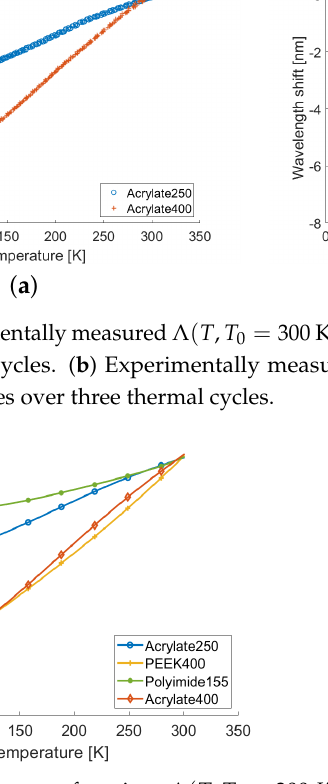
Figure 5. Thermal response functions Λ ( T , T 0 = 300 K ) of all the fiber samples. Table 2. Maximum wavelength-shift differences and interpolation residuals, absolute and relative to the measured wavelength-shift